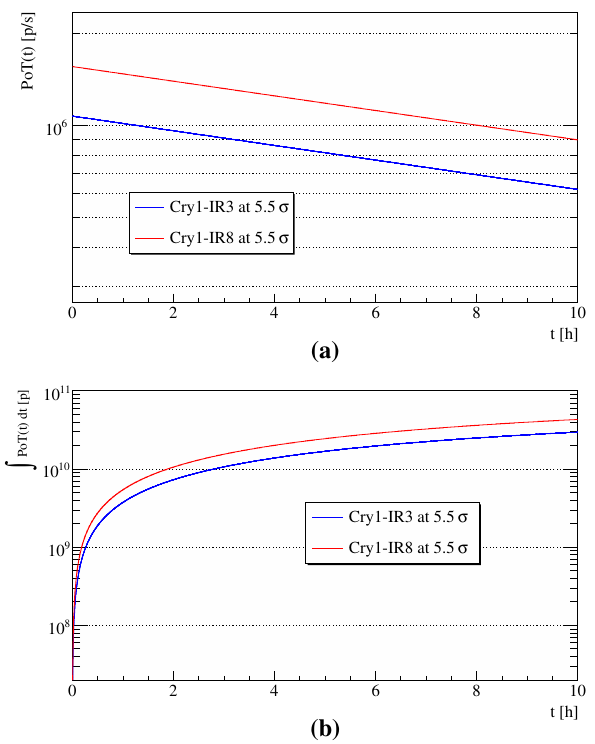
Fig. 14 Expected instantaneous ( a ) and integrated ( b ) PoT for both layouts with Cry 1 at 5 . 5 σ during a 10 h fill